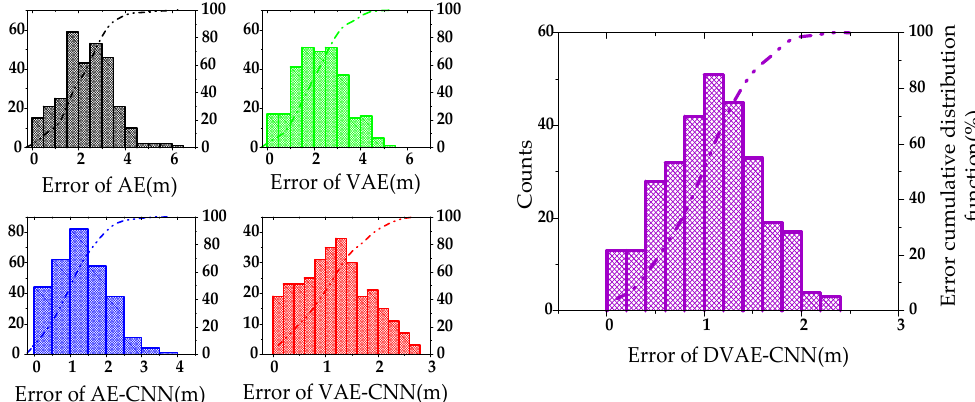
Figure 17. Comparison of positioning accuracy of different models.